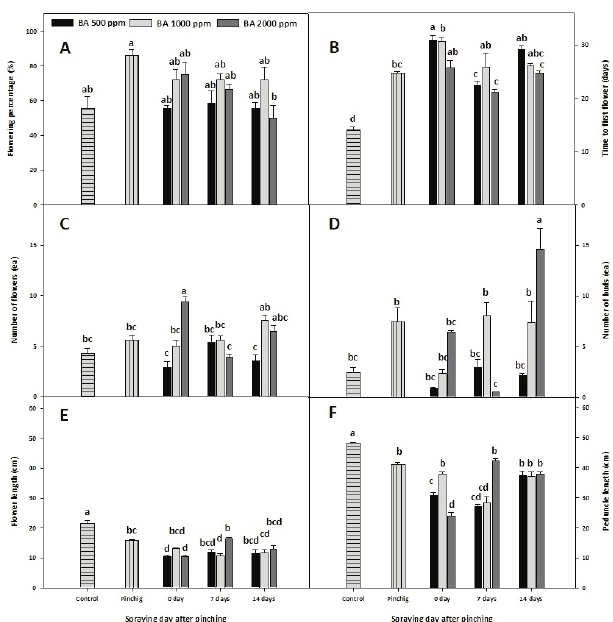
Fig. 2 ­ Flowering characteristics of V. dahurica with pinching and BA spray